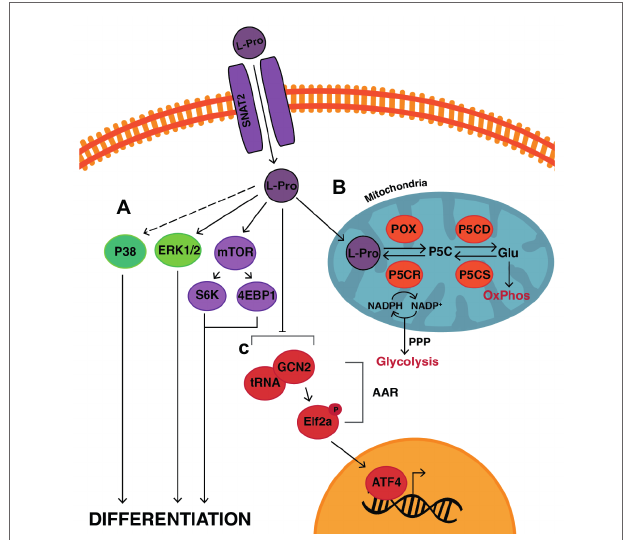
FIGURE 9 | Model of L-proline-mediated differentiation of mESCs to EPL cells. L-Pro enters the cell via the SNAT2 transporter (Tan et al., 2011) where it (A) acts on various signaling pathways including the amino acid- sensing signaling mTOR pathway, ERK and P38 pathways to induce differentiation (Lonic, 2007; Washington et al., 2010; Tan et al., 2016). (B) L-Pro is metabolized to pyrroline-5-carboxylate (P5C) by proline oxidase (POX) via the proline cycle in the mitochondria. P5C can then be converted to glutamate (Glu) by P5C dehydrogenase (P5CD). Glu is further converted to alpha-ketoglutarate, which enters the TCA cycle with subsequent production of ATP via oxidative phosphorylation (OxPhos). Glu can also be converted to L-Pro via the sequential actions of P5C synthase (P5CS) and P5C reductase (P5CR). This conversion produces NADP + , which is required to stimulate the pentose phosphate pathway (PPP) in the cytoplasm of the cell (Pandhare et al., 2009; Phang et al., 2010). The PPP is required to generate the ribose components needed for DNA and RNA synthesis and is coupled with aerobic glycolysis to generate ATP in highly proliferative cells such as ESCs and cancer cells (Liu et al., 2015). Stimulation of the PPP and glycolysis in the presence of L-Pro (Liu et al., 2015) may stimulate the differentiation of mESCs to EPL cells and support the increased proliferation rates observed in EPL cells. (C) When mESCs are starved of L-Pro, the amino acid response (AAR) pathway is activated to control L-Pro production and uptake into the cell. Free prolyl-tRNA (i.e., not loaded with L-Pro) binds to General Control Non-Depressible-2 (Gcn2) kinase which phosphorylates Eukaryotic Initiation Factor-2 (eIF2), resulting in Activating Transcription Factor-4 (Atf4) regulating the expression of genes involved in L-Pro transport and metabolism. The net result of this autoregulatory loop is self-limiting concentrations of L-Pro resulting in mESC self-renewal (D’Aniello et al., 2015). When L-Pro is added exogenously, this pathway is overwhelmed triggering